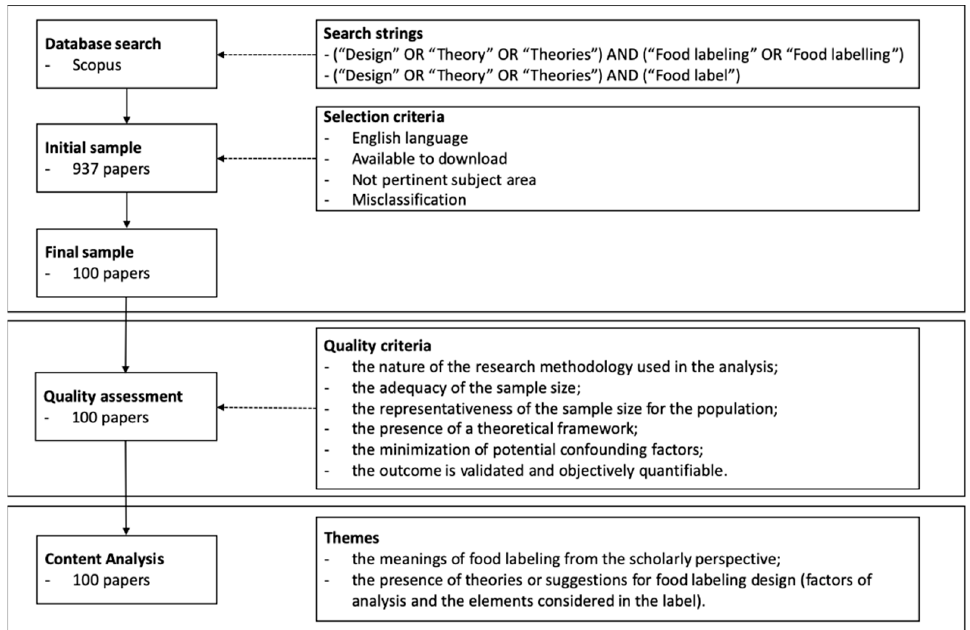
Figure 1. Research methodology in domain-based systematic literature review.